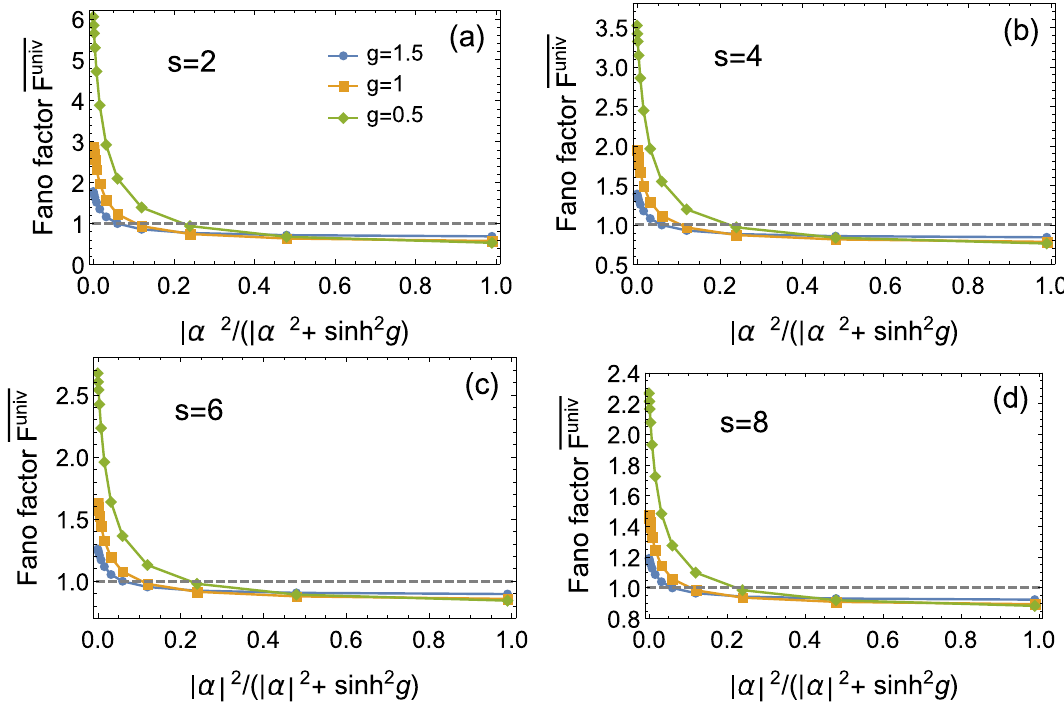
2 /( 2 sinh 2 g ) , where α α | | | | +